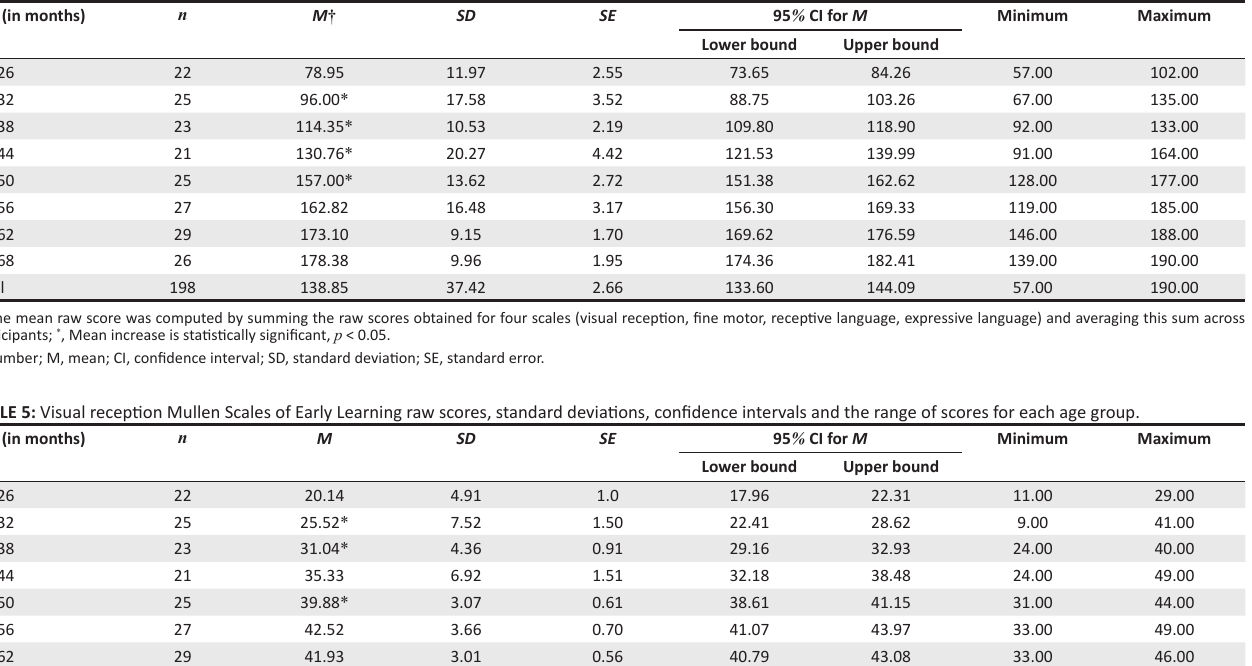
39–44 51–56 57–62